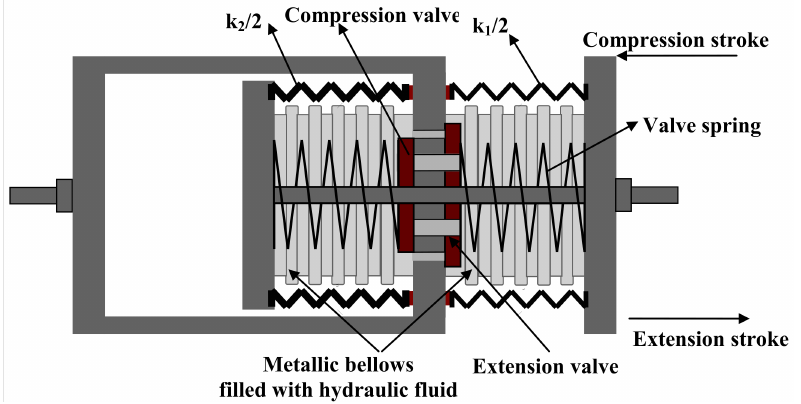
Figure 4. Design principle of a device with PWL asymmetric damping and stiffness characteristics.